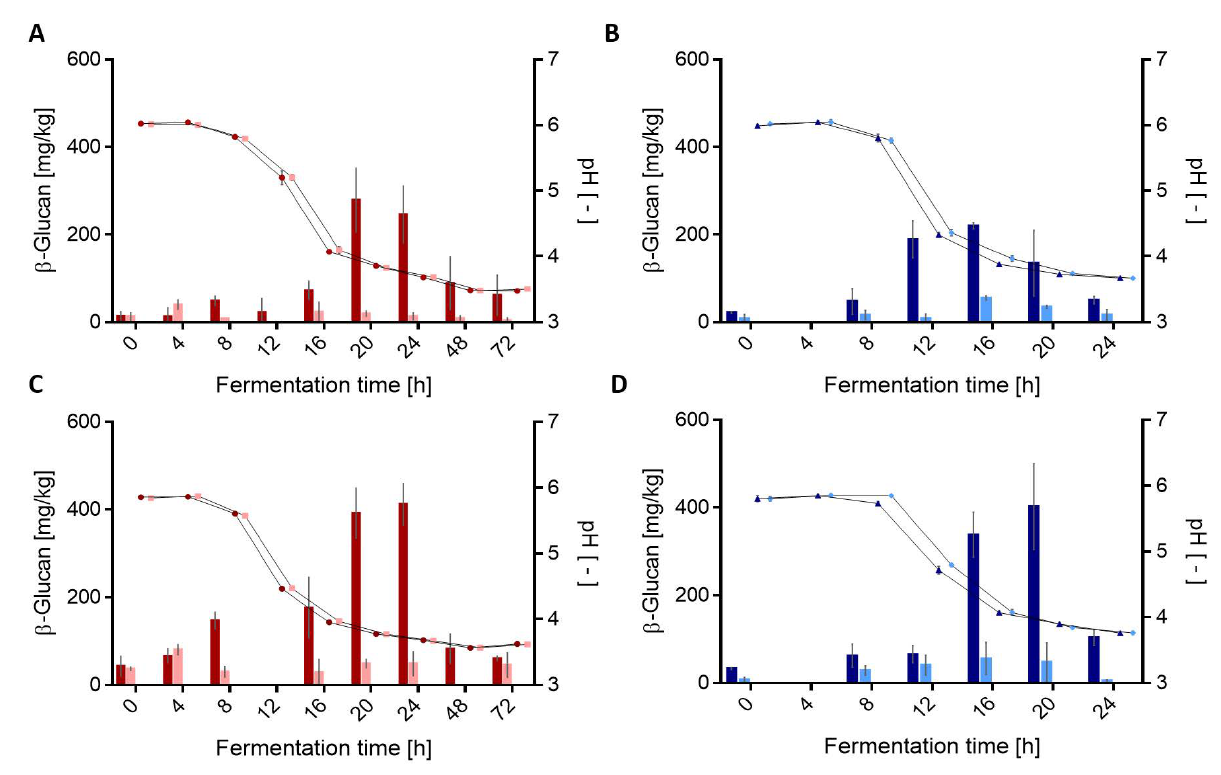
Figure 2. Changes in β -glucan concentration measured by ELISA and pH values during wheat and rye sourdough fermentations. ( A ) L. brevis TMW 1.2112 ( • ) and L. brevis TMW 1.2320 ( (cid:4) ) in wheat sourdough. ( B ) P. claussenii TMW 2.340 ( (cid:78) ) and P. claussenii TMW 2.2123 ( (cid:7) ) in wheat sourdough, ( C ) L. brevis TMW 1.2112 and L. brevis TMW 1.2320 in rye sourdough, and ( D ) P. claussenii TMW 2.340 and P. claussenii TMW 2.2123 in rye sourdough. The β -glucan amounts and pH values were analyzed by biological triplicates with standard